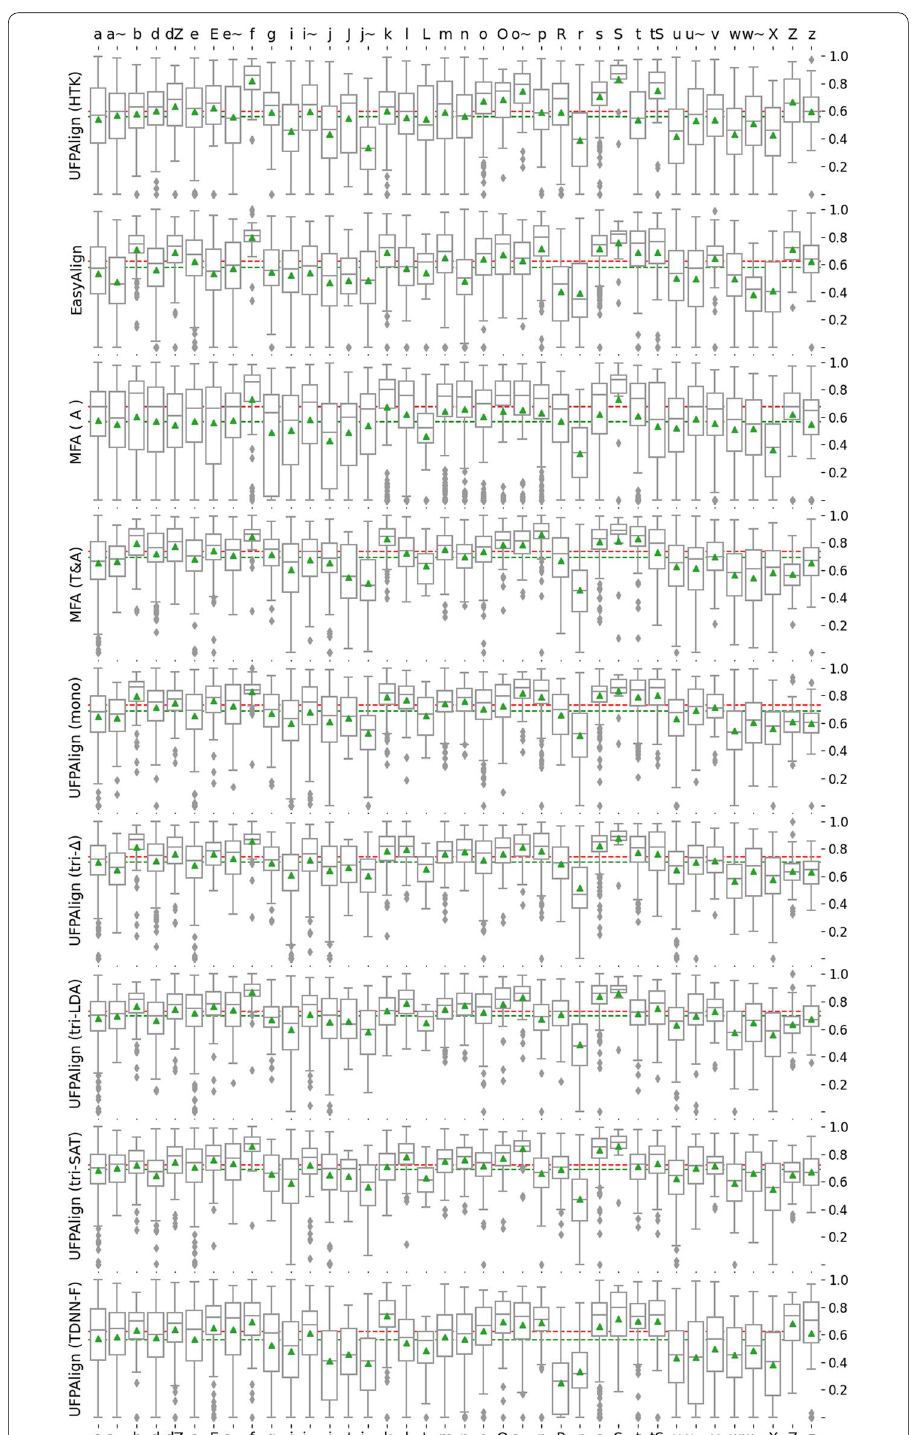
Fig. 13 IoU values per phoneme on the utterances of the male